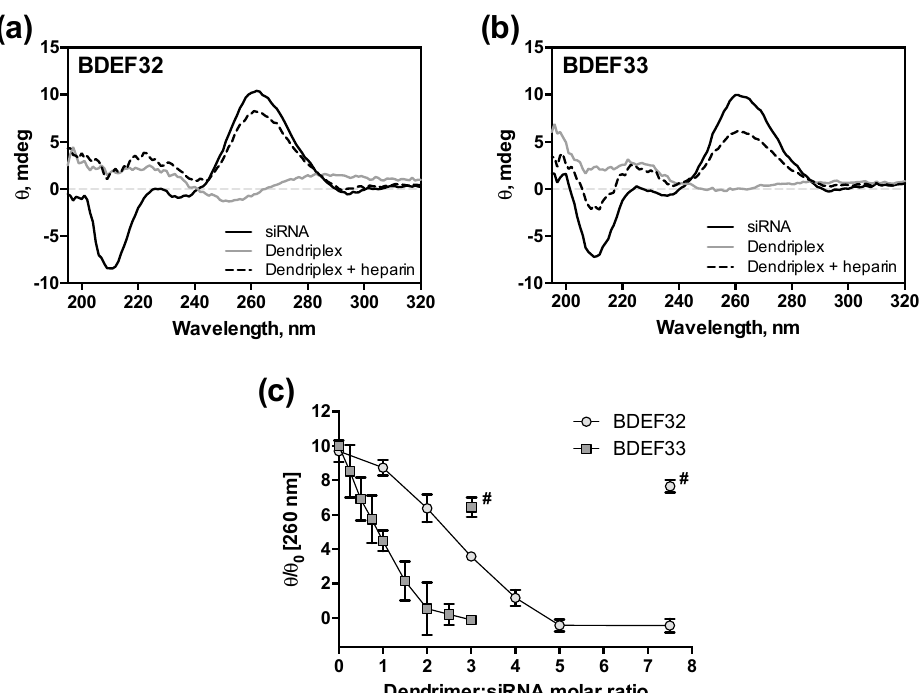
Figure 3. Circular dichroism (CD) spectra of siRNA Bcl-xL (2 µM) in the presence of the carbosilane dendrimers of ( a ) the second ([BDEF32] = 15 µM) and ( b ) the third generations ([BDEF33] = 6 µM); ( c ) changes of ellipticity (at 260 nm) of the dendriplexes formed by siRNA Bcl-xL and dendrimers BDEF32 and BDEF33 (# marks samples after heparin treatment). Conditions: 1 × PBS (10 mM phosphate buffer, pH 7.4, 137 mM NaCl, 2.7 mM KCl), 25 °C.